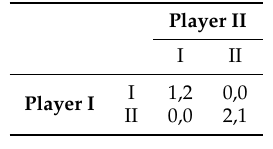
Table 8. A Battle-of-Sexes